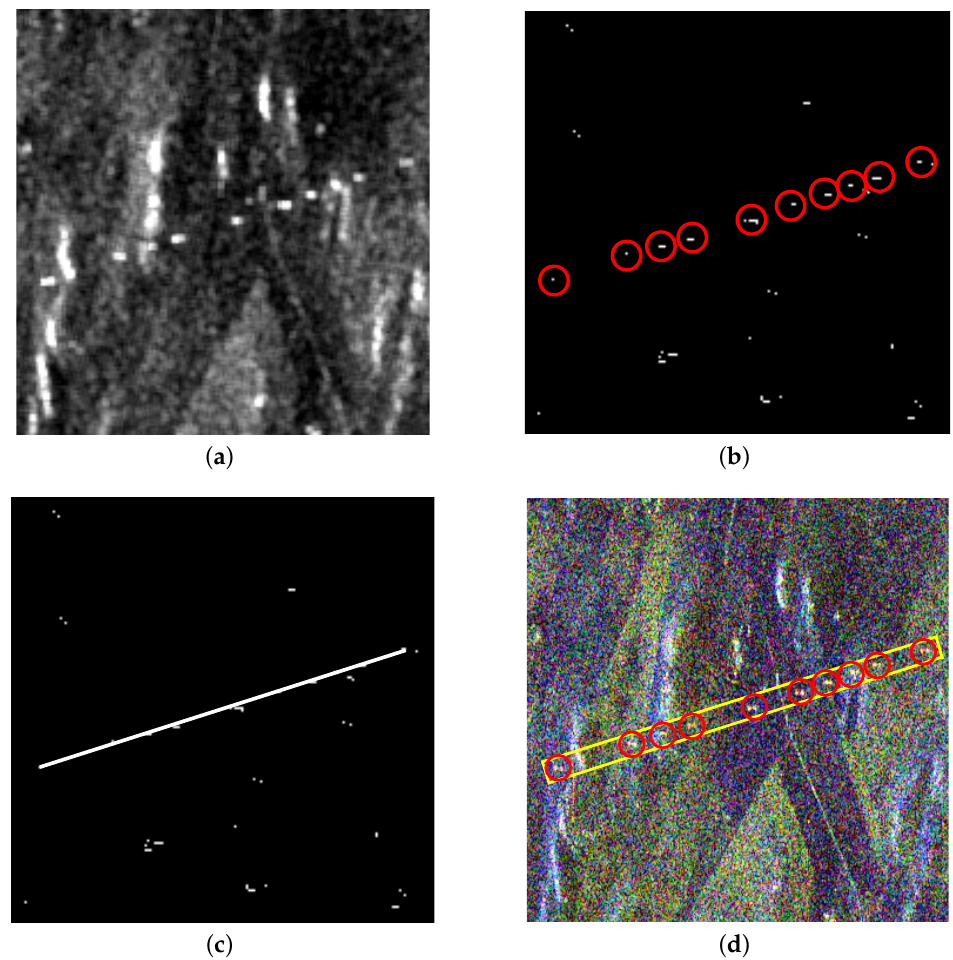
Figure 9. ( a ) filtered image based on TF analysis; ( b ) point-like target detection results; ( c ) a-contrario extraction result; and ( d ) extraction result marked on the original